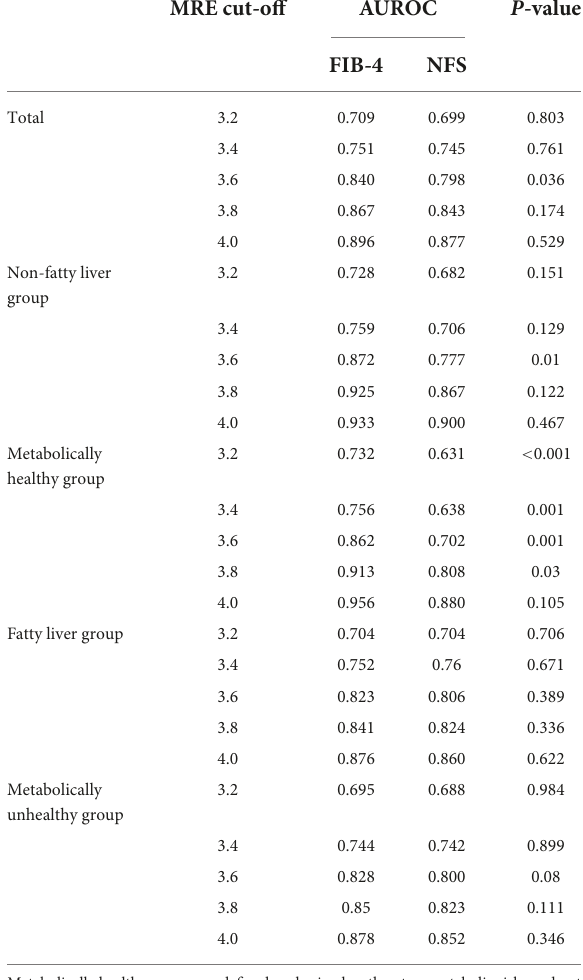
TABLE 4 Comparison of AUROC for hepatic fibrosis between FIB-4 and NFS in various groups according to different MRE cut-off values. ( Figure 3 ). The accuracy of the current FIB-4 low cut-off MRE cut-off AUROC P -value FIB-4 NFS